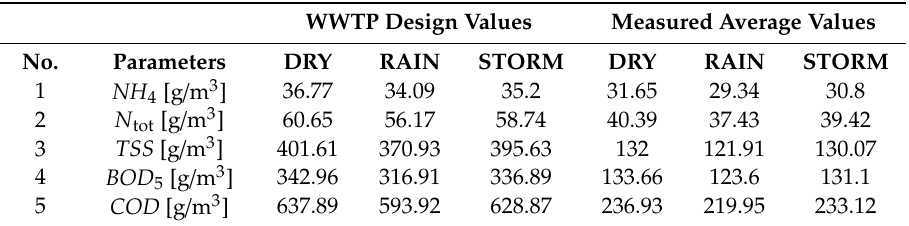
Table 2. The average concentrations in the influent in the three considered regimes.